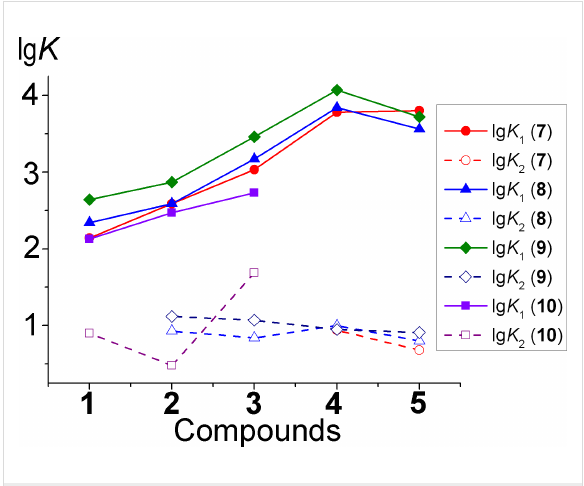
Figure 5: Stability constant dependence for the complexes (lg K ) of molecular clips 1 – 5 with guests 7 – 10 on the size of crown ether cycles in acetonitrile at 20